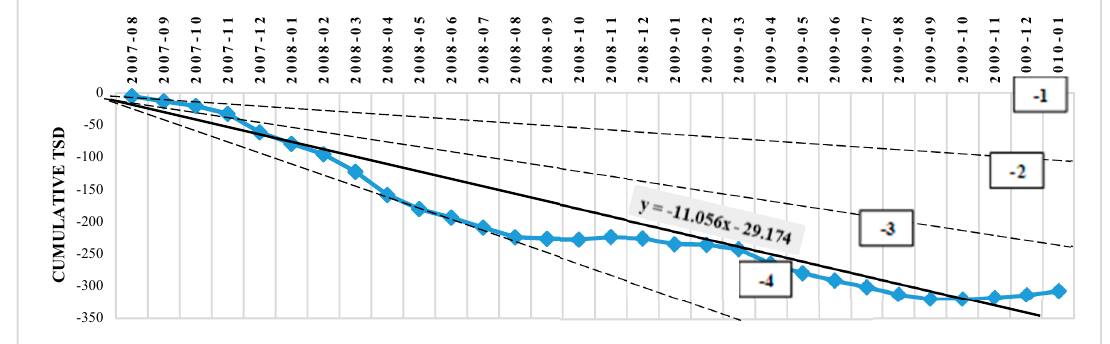
Figure 2. Terrestrial Storage Deficit (TSD) Cumulative graph and division of this graph area into four equal parts.